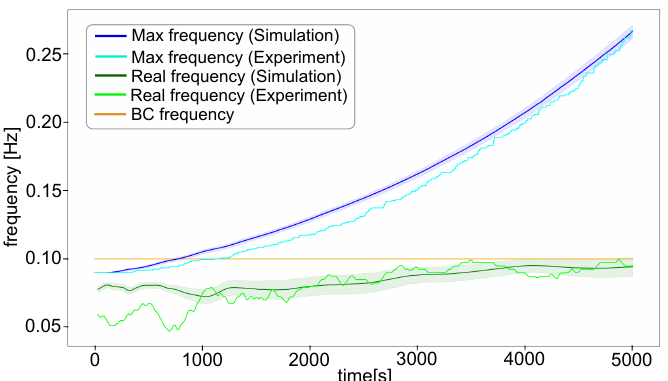
Figure 15. Comparison of the frequency of service provision over time between the experimental and simulation